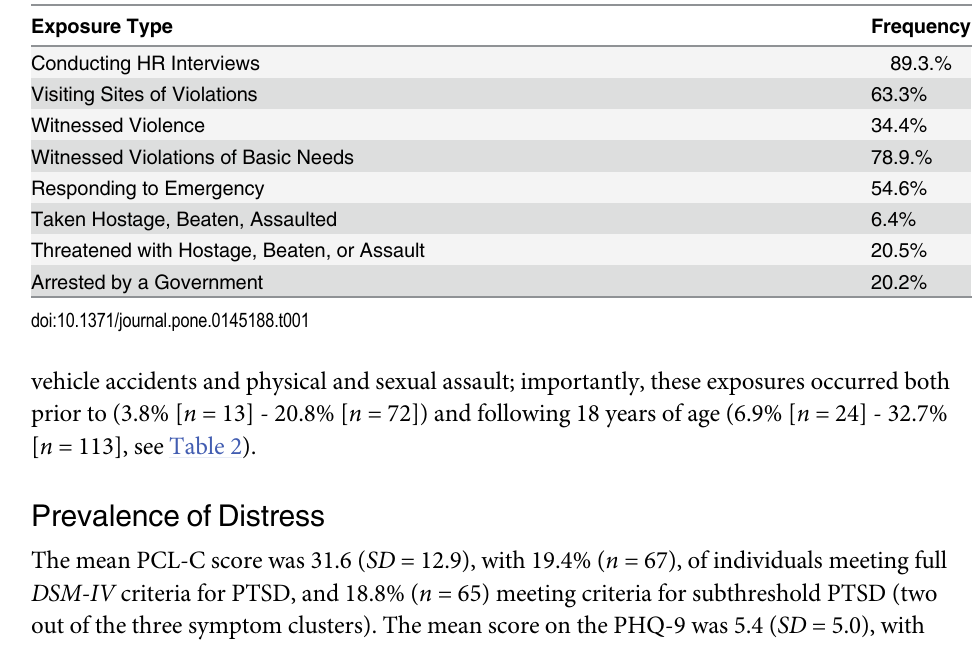
Table 1. Frequency and type of trauma exposure reported in Human Rights